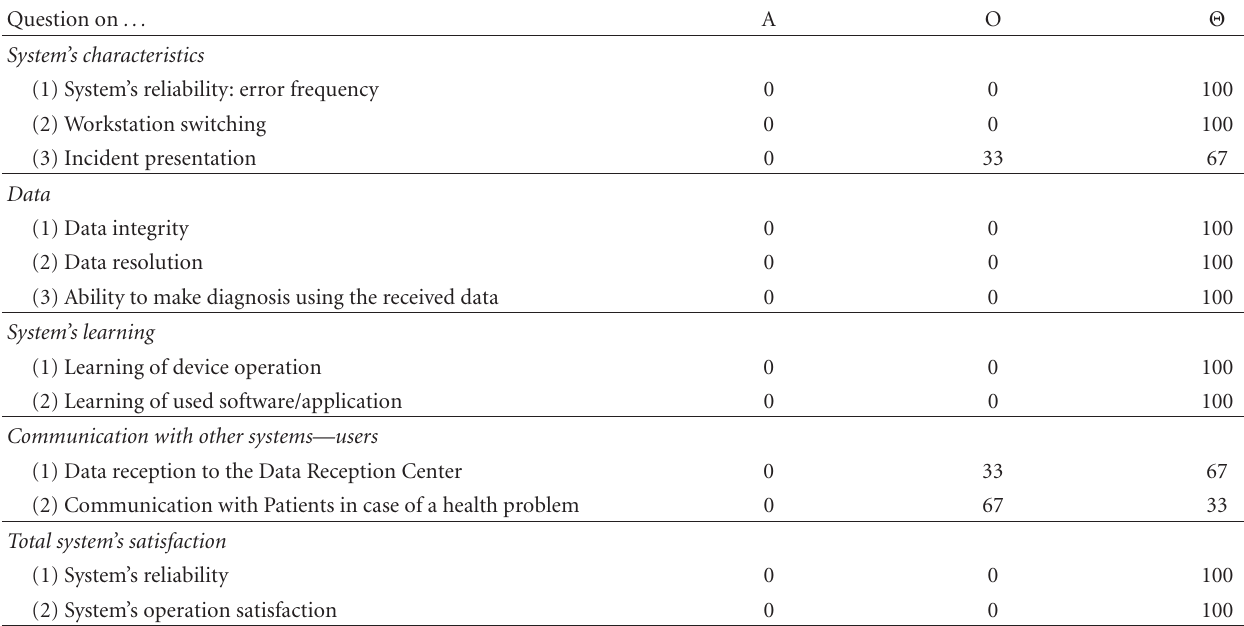
Table 7: Doctor’s questionnaire